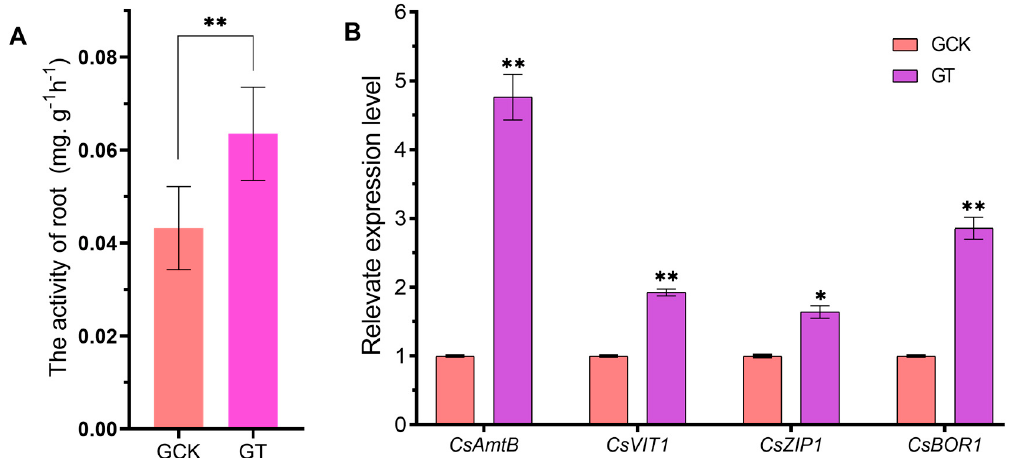
being repotted. GCK, control group in greenhouse trial, GT, treatment group in greenhouse trial.